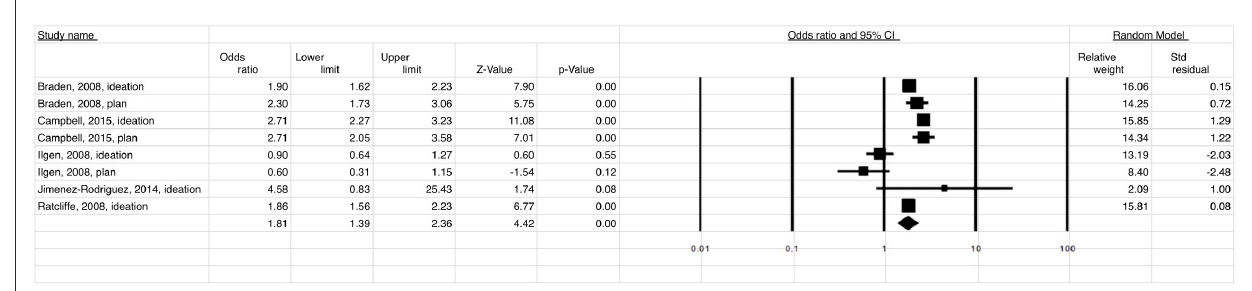
FIGURE6 Relationship between risk of suicide ideation/planning (OR = 1.81) in patients with back/neck pain when compared to healthy controls.